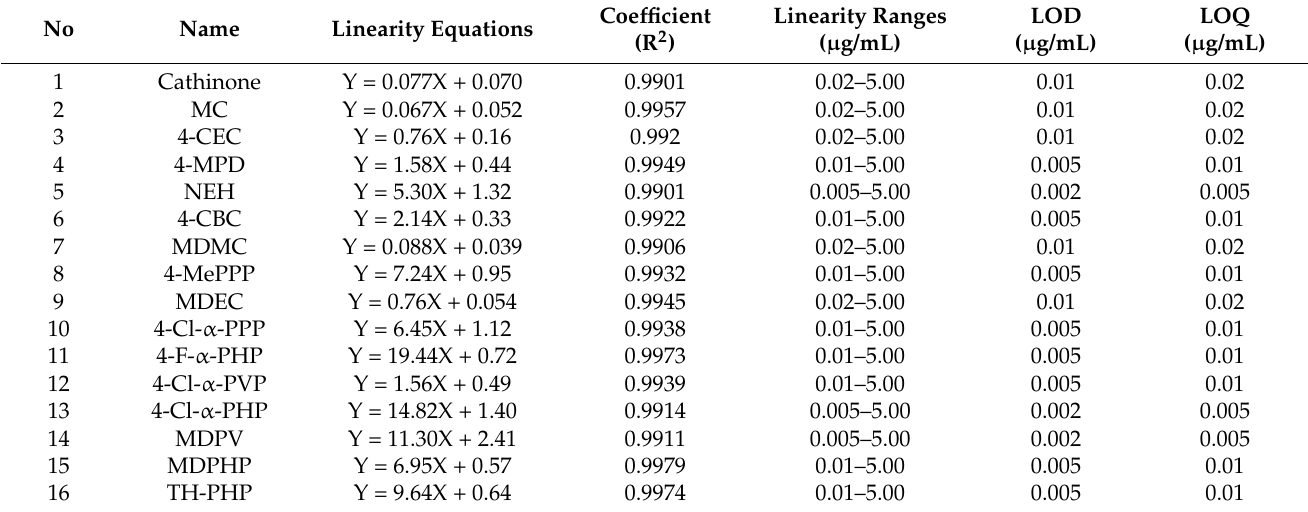
Table 4. Linearity equations, coefficients, linearity ranges, LODs and LOQs of 16 kinds of synthetic cathinones in human urine.